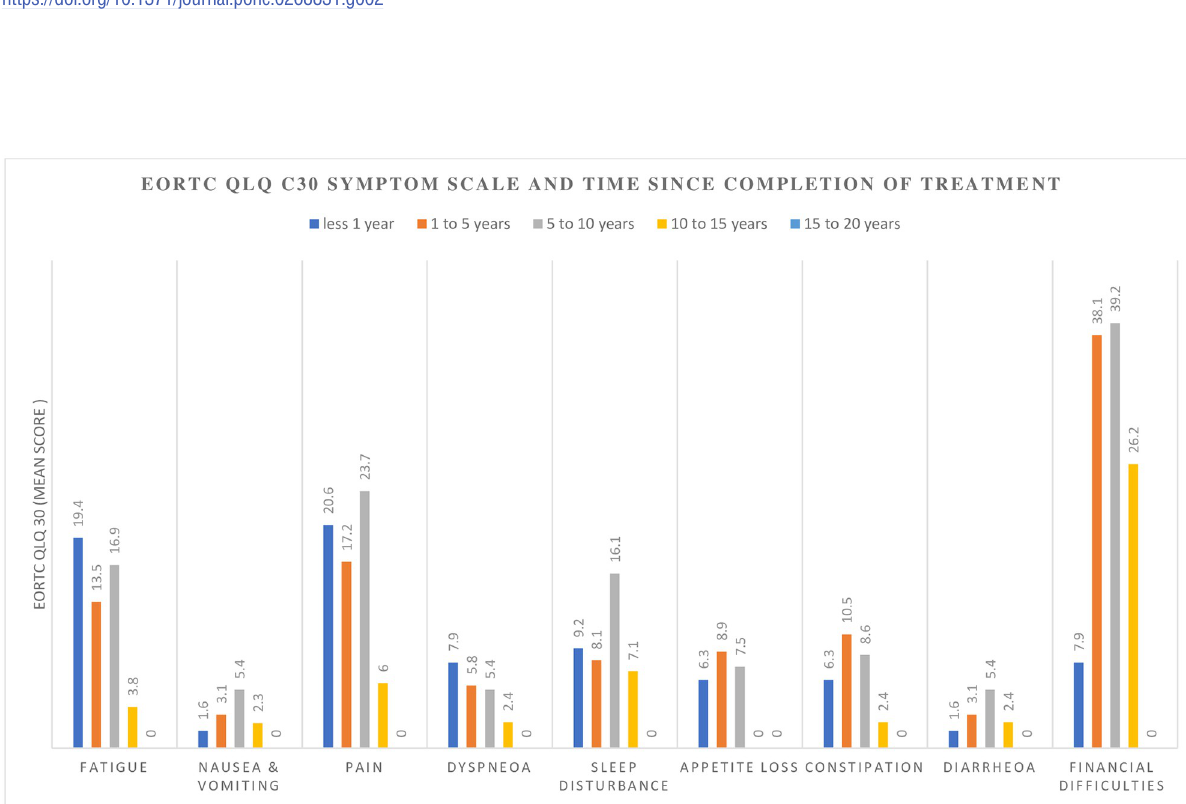
PLOS ONE | https://doi.org/10.1371/journal.pone.0268831 June 3, 2022 11 /